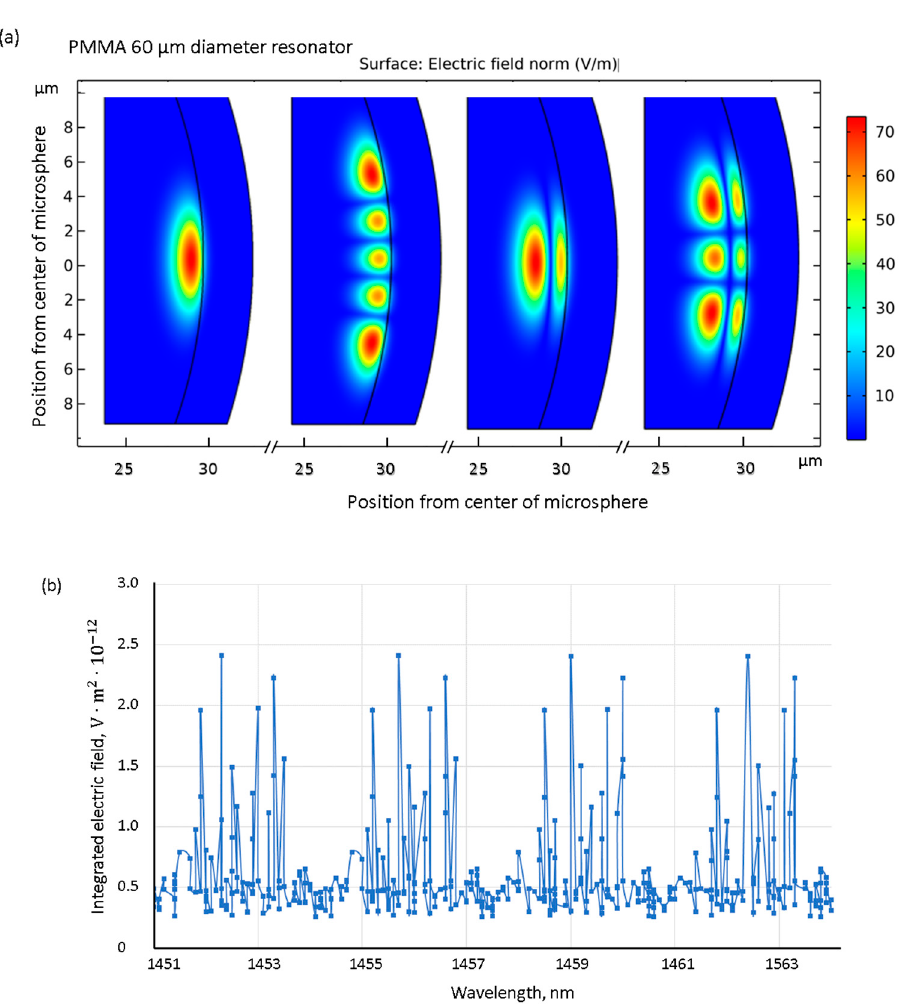
Figure 6. COMSOL simulation results from a perfect sphere with a smooth surface. ( a ) A sample of four modes in the same microresonator (radius is 30 µm). The mode numbers for angular mode p = l − m and radial mode q from left to right are p = 0, q = 1; p = 4, q = 1; p = 0, q = 2, and p = 2, q = 2; ( b ) integral value of electric field inside the PMMA microsphere at different